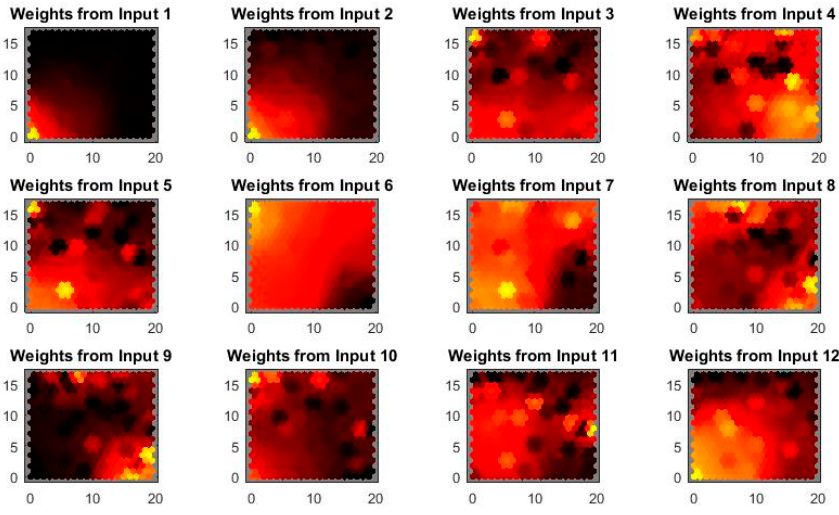
Figure 5. Weight distances.